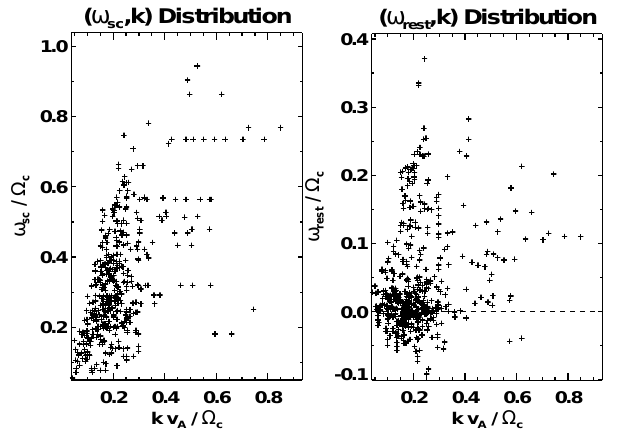
Fig. 7. The ( ω , k )-distributions in the spacecraft frame (left) and in the plasma rest frame (right). (cid:127) c is the proton cyclotron frequency and V A the Alfv´en velocity.